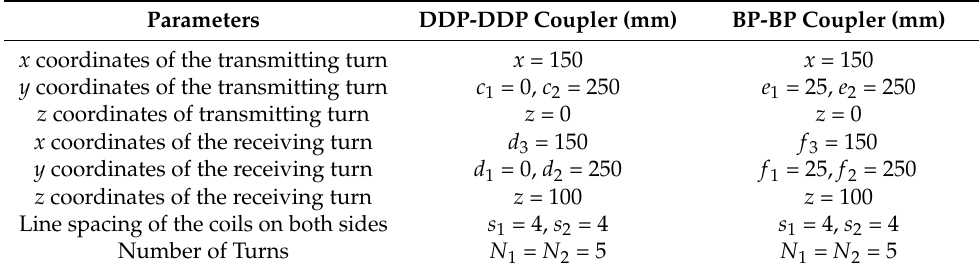
Table 2. Parameters of the finite element model for the two polarized